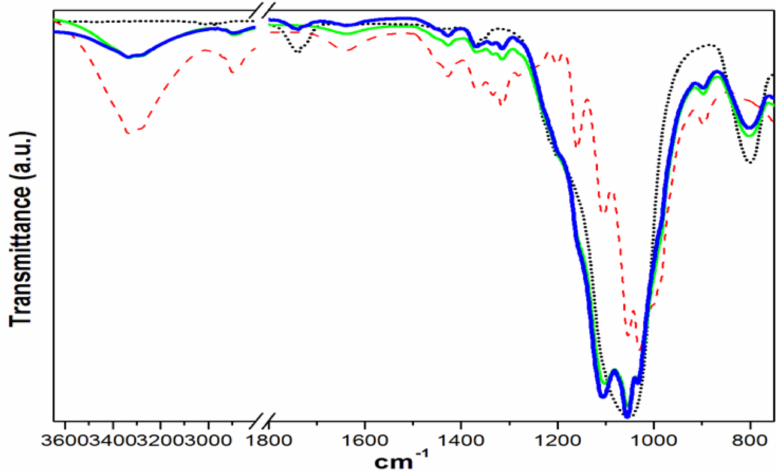
Figure 1. FTIR spectra of C20 (red dash line), NSi (black dot line), CP1 (green line), CP2 (blue